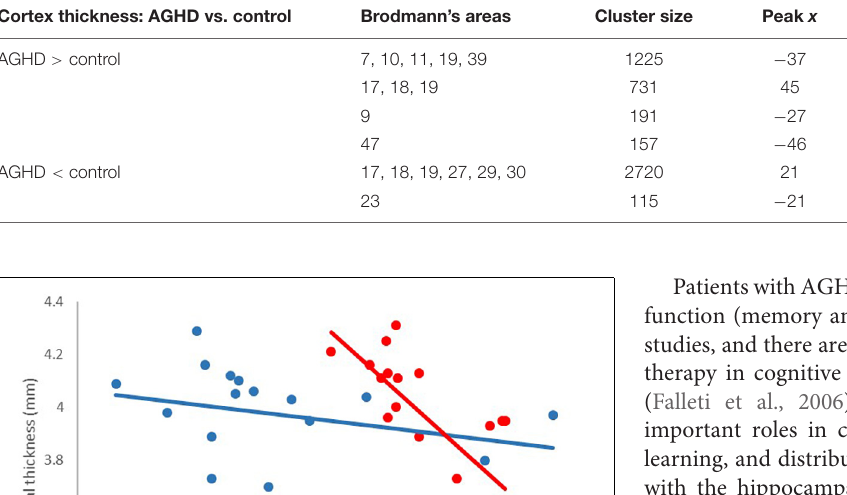
TABLE 3 | Regional variation of cerebral cortex thickness in AGHD patients compared with normal control. Cortex thickness: AGHD vs. control